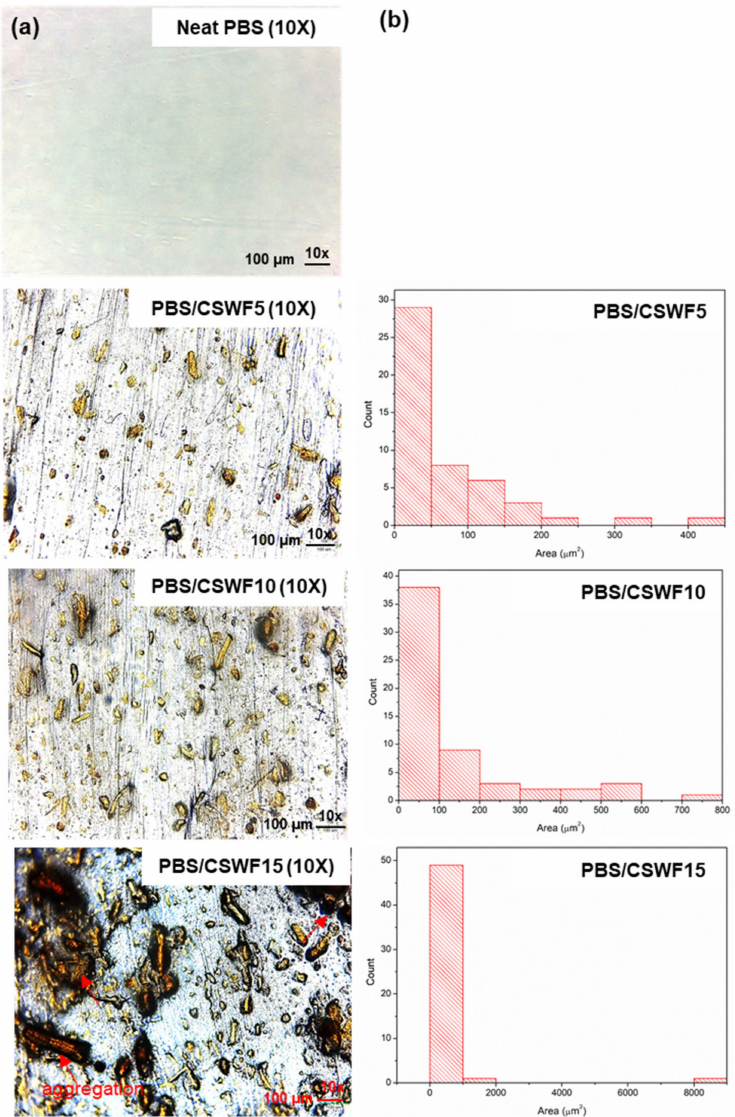
Figure 4. ( a ) Optical microscope images of PBS composite films at magnification of 10 × and 40 × , and ( b ) fiber diameter and its aggregation area analyzed by ImageJ